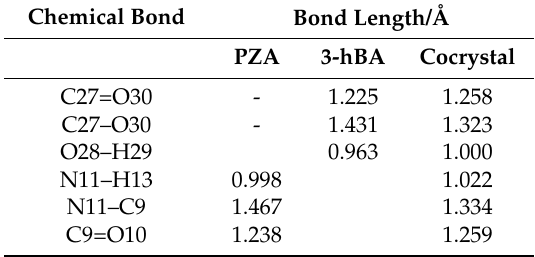
Table 3. Change of characteristic bond lengths between PZA, 3-hBA, and their